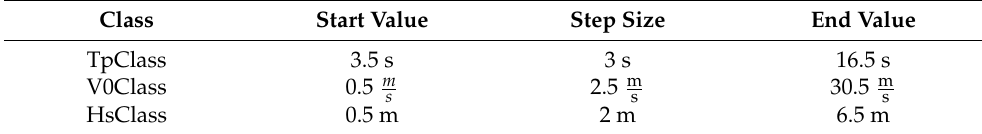
Table 3. Classification of